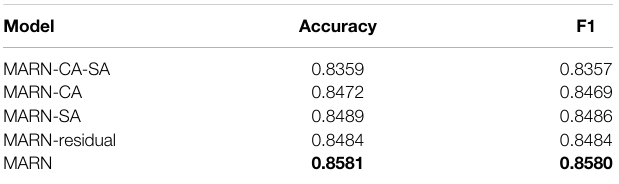
TABLE 4 | Results of different ablation models on a dataset.